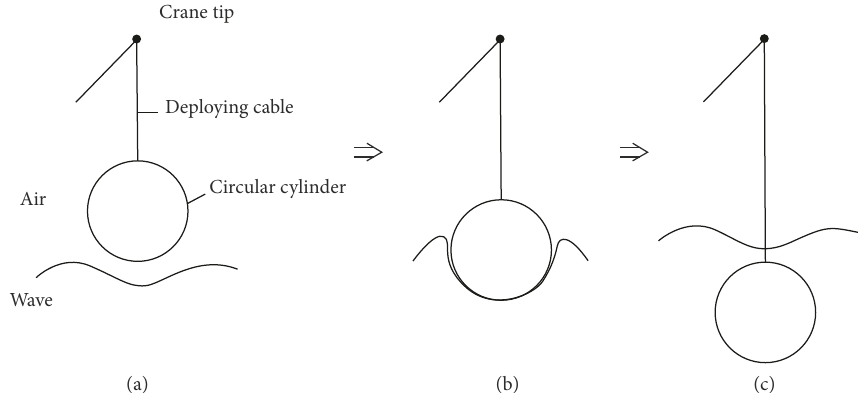
Figure 1: A circular cylinder lowering through the wave zone: (a) dry state; (b) partially immersed state; (c) fully immersed state.